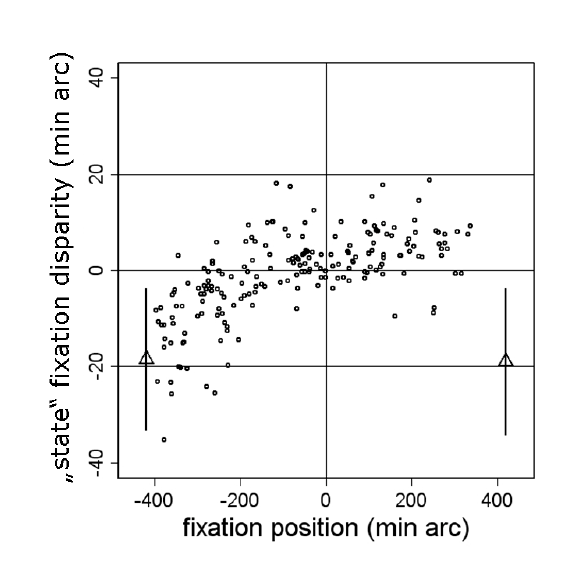
Figure 6: “State” fixation disparity (min arc) as a function of fixation position (min arc) within a sentence. Open triangles show the “state” fixation disparity (± SD), which was measured at the starting and end cross, respectively. Additionally, horizontal lines mark the edges of a letter (20 min arc), for the crossed (upper line) and uncrossed (lower line) condition,